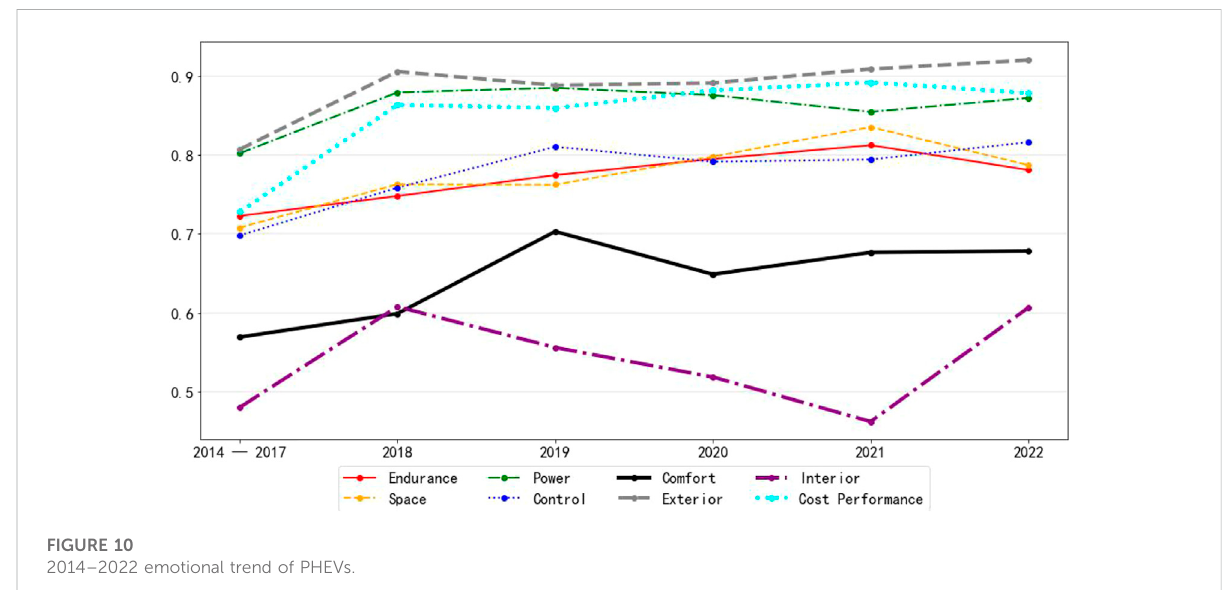
FIGURE 10 2014 – 2022 emotional trend of PHEVs.